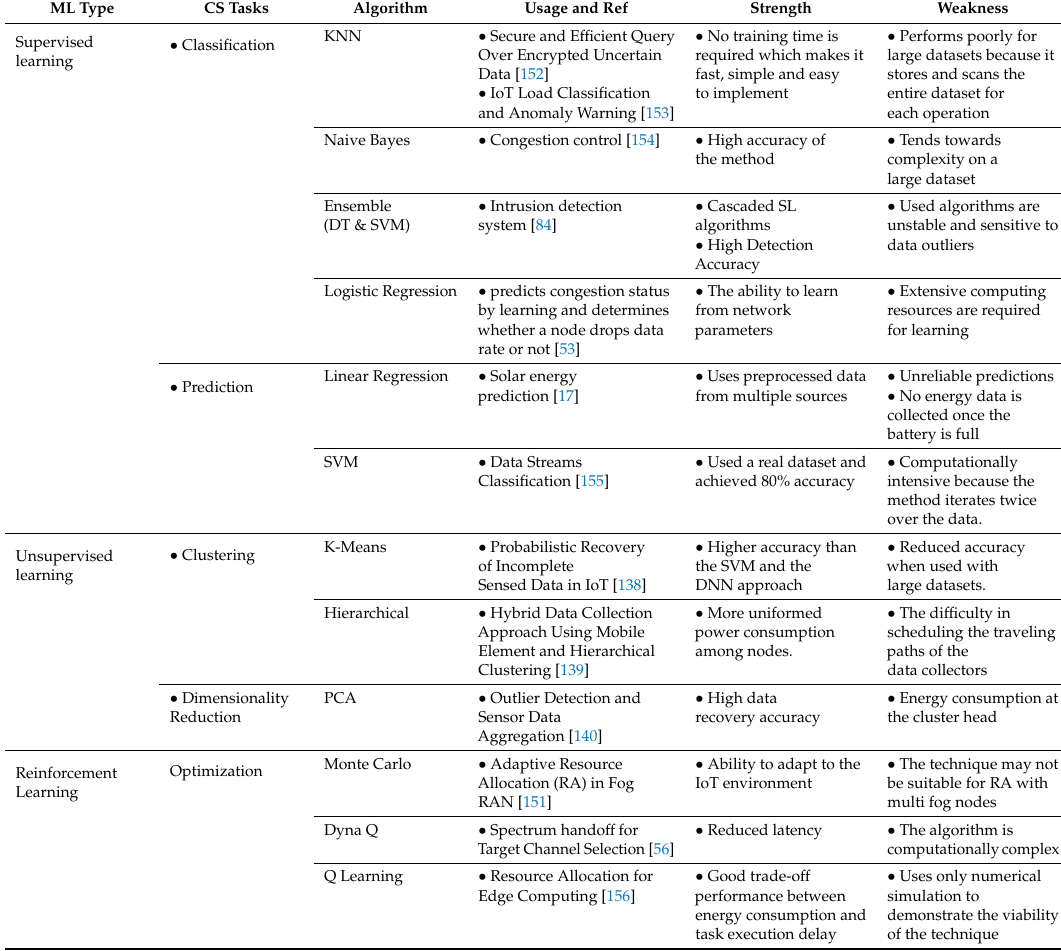
Table 6. Some ML algorithms and selected works with their strength and weaknesses for cognitive sensing